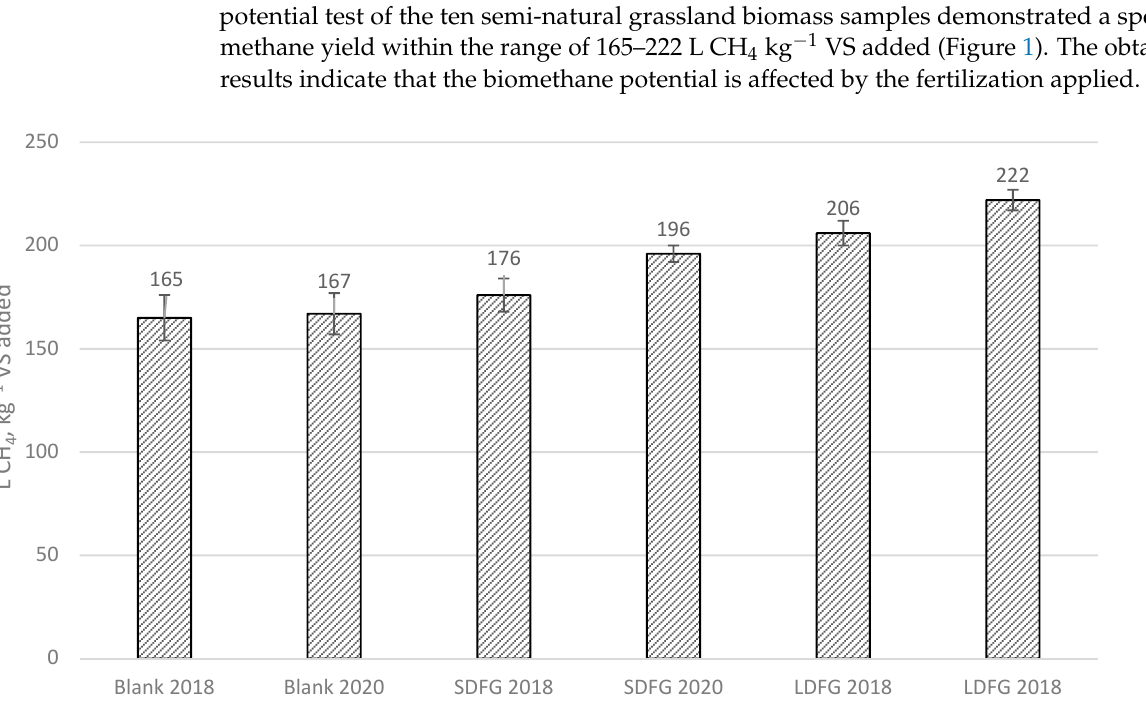
Figure 1. Biogas potential results for solid (SDFG) and liquid (LFDG) digestate fertilized grass samples during the years 2018 and 2020. Note: Data represented as mean ± standard deviation.